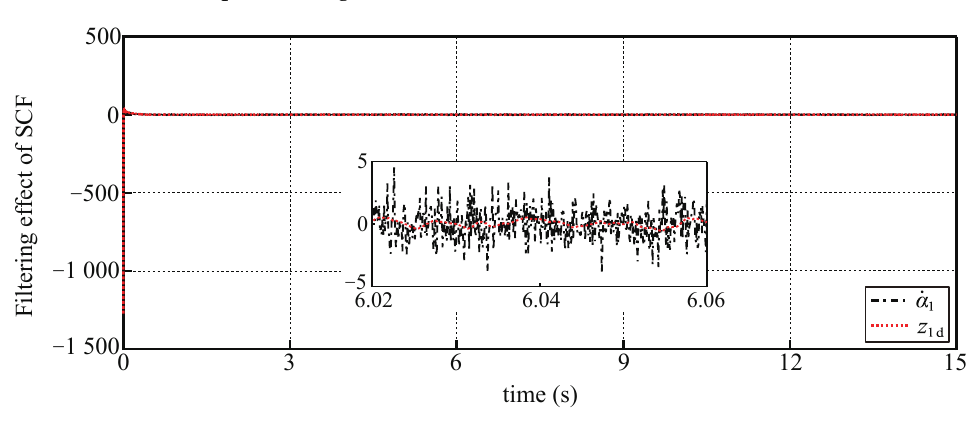
Figure 9. Comparison results between ˙ α 1 and the output of the SCF z 1d